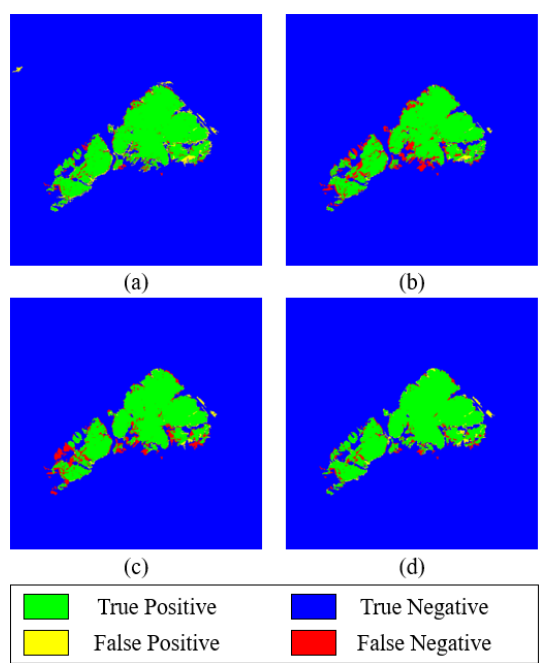
Figure 5. Burned area mapping results from pixel-based image analysis with two pairs of images; (a) NDVI, (b) NBR; with one pair of images (c) NDVI, (d)